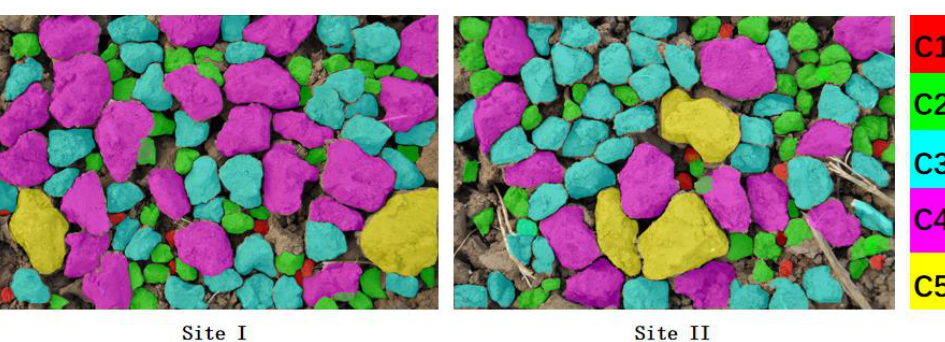
Table 4. Distribution statistics of soil blocks.